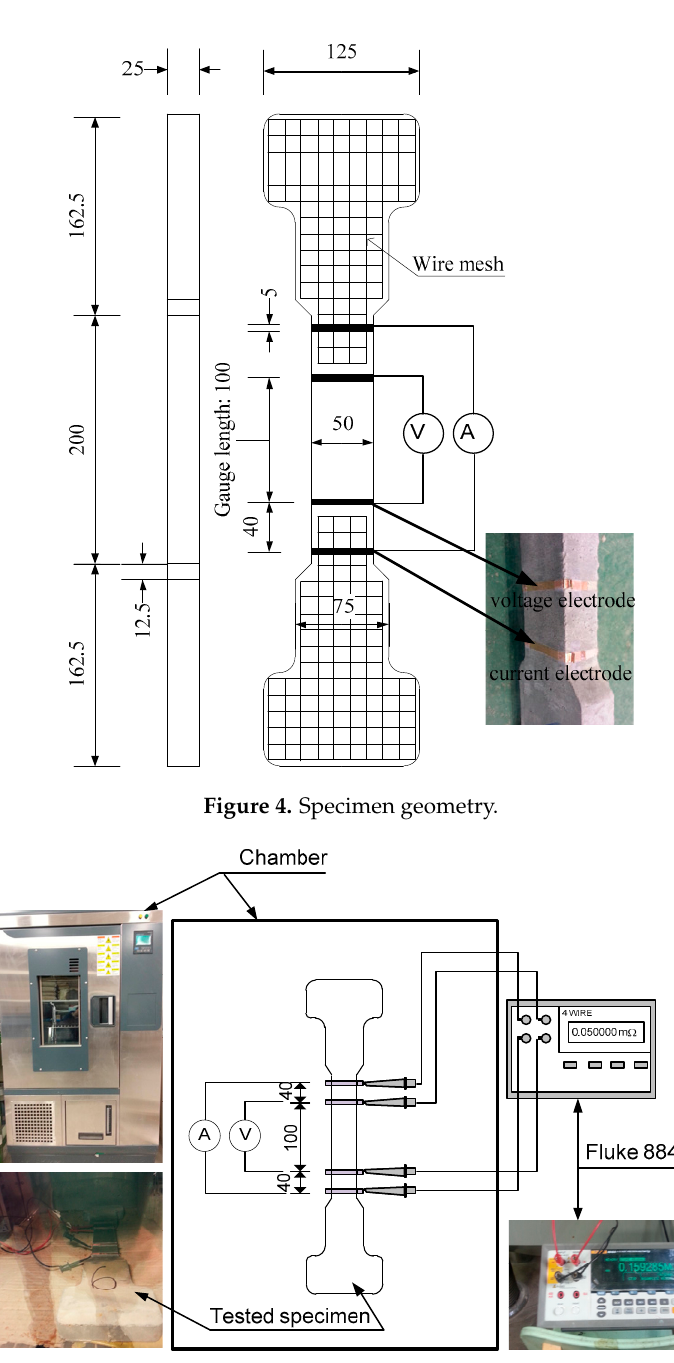
Figure 5. Test setup using a chamber to measure specimen resistance.